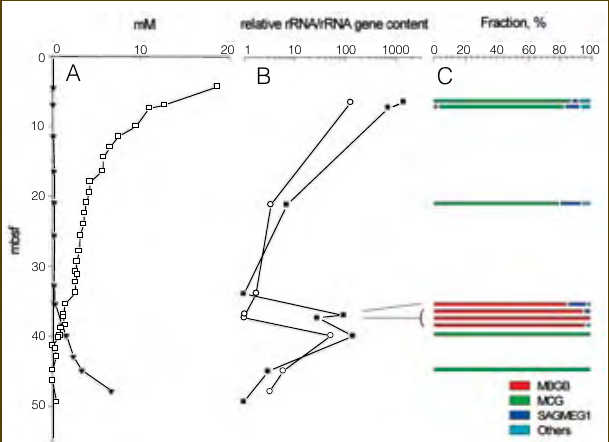
Figure 3. Population structure of uncultured deep subsurface archaea and rRNA concentration in geochemically distinct sediment hori- zons of ODP Site 1227 (Sørensen and Teske, 2006). [A] Concentra- tion profile of sulfate (squares) and methane (triangles) at Site 1227. [B] Relative amount of rRNA (black squares). A value of 1 corresponds to the detection limit. The data are compared with the amount of ar- chaeal DNA in each sample quantified by Q-PCR (circles, redrawn from Schippers et al., 2005). [C] Phylogenetic composition of clone libraries from each depth. The sample from 37.75 mbsf was extracted twice and amplified using two primer sets, yielding 3 independent clone libraries. MBG-B: Marine benthic group B, MCG: Miscellaneous Crenarchaeotal Group, SAGMEG-1: South African Gold Mine Euryar- chaeotal group 1. These archaeal lineages are shown in red in the subsurface phylogeny in Fig.